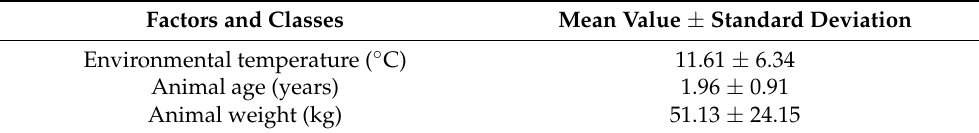
Table 2. Mean values for environmental temperature and wild boar characteristics.